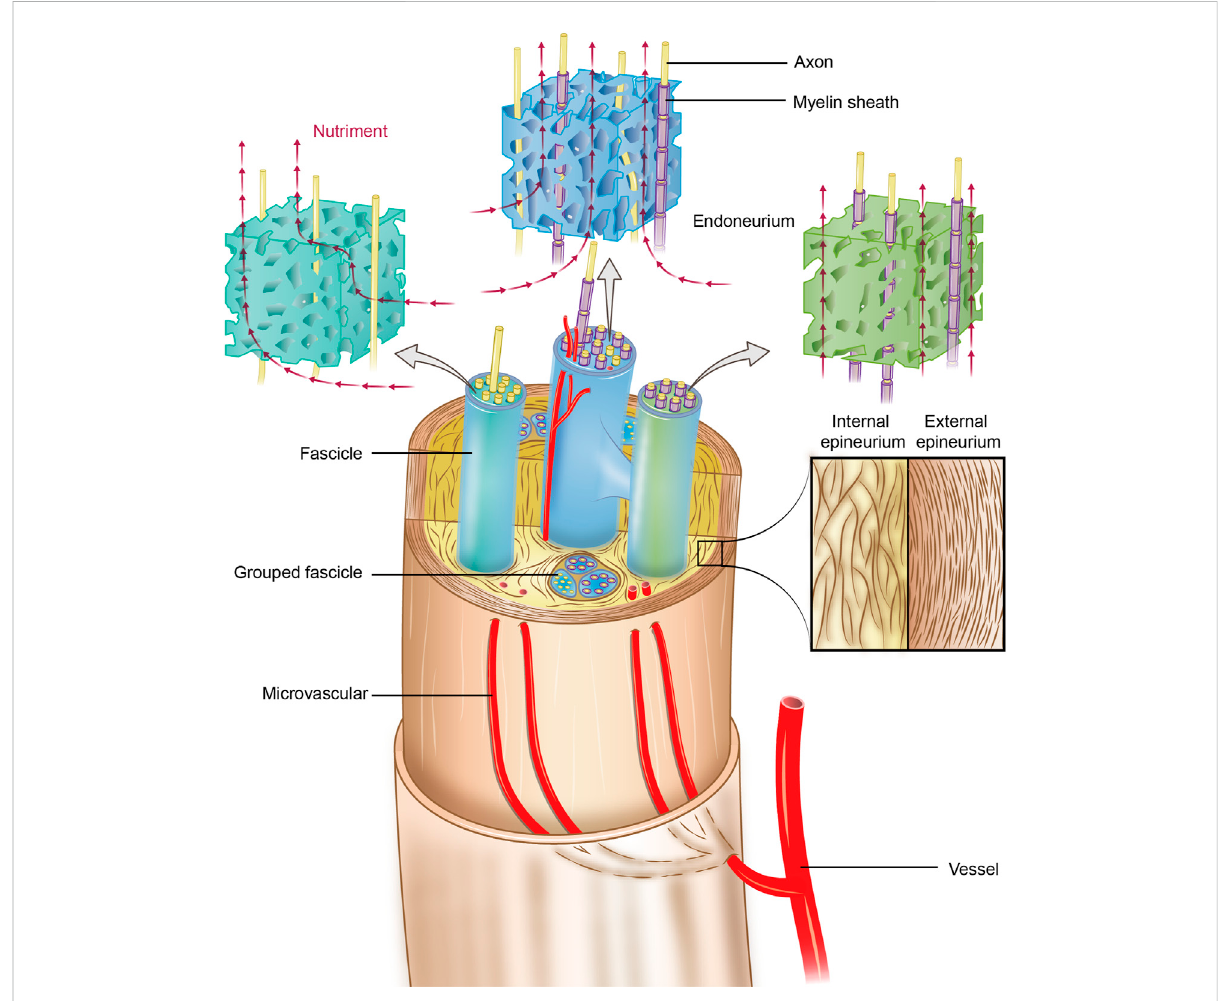
FIGURE 1 Schematic of the anatomy of the peripheral nerve ECM system. The endoneurium is an anisotropic porous structure that provides nutriment diffusivity longitudinally. The perineurium surrounds groups of axons to form fascicles, and the epineurium binds individual nerve fascicles into a nerve trunk. The internal microvasculature runs longitudinally within the internal epineurium and connects with the external vasculature at various points; thus, it plays a particularly vital role in nerve healing and repair after